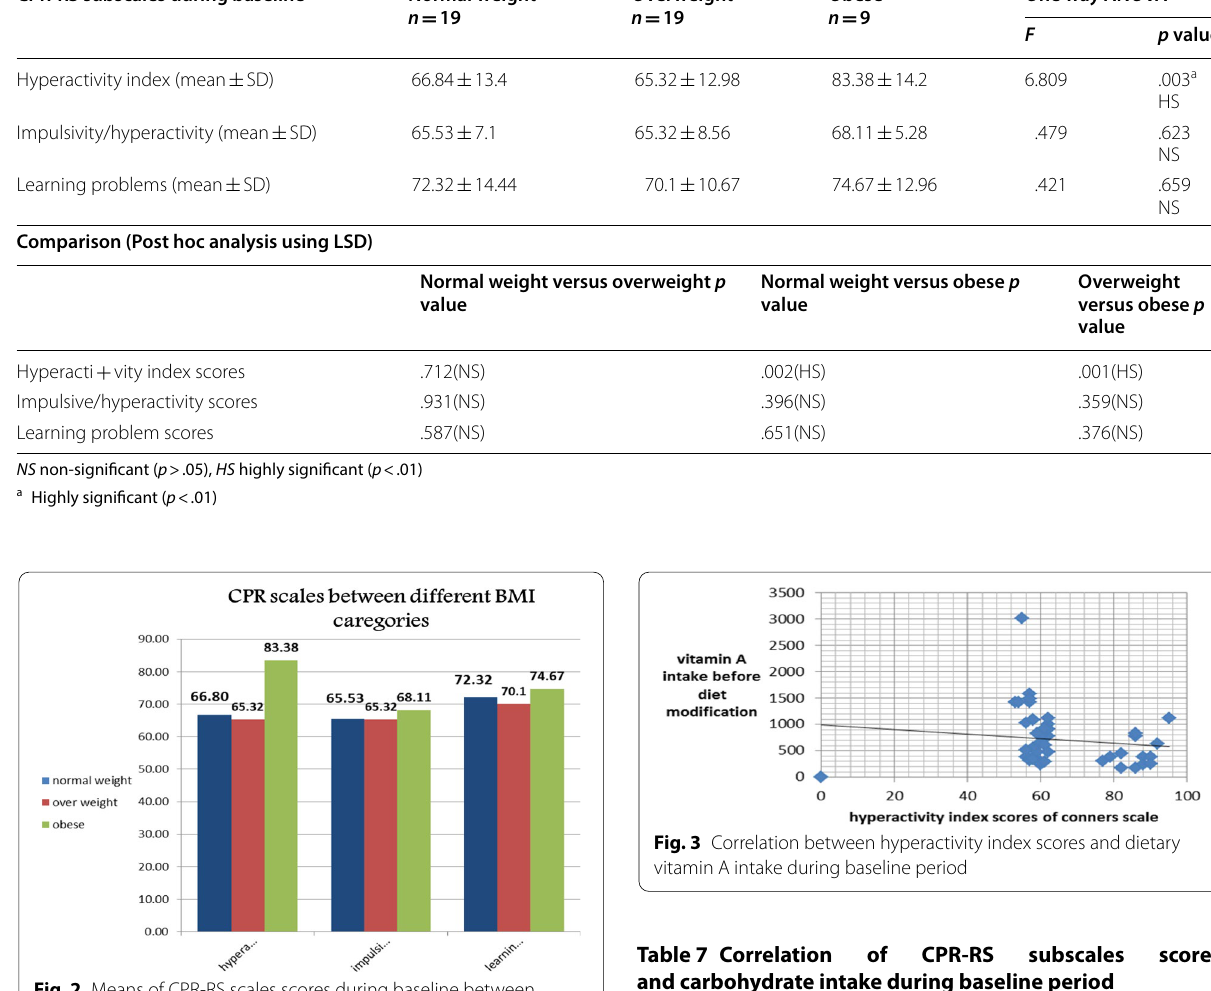
Fig. 2 Means of CPR-RS scales scores during baseline between different BMI categories